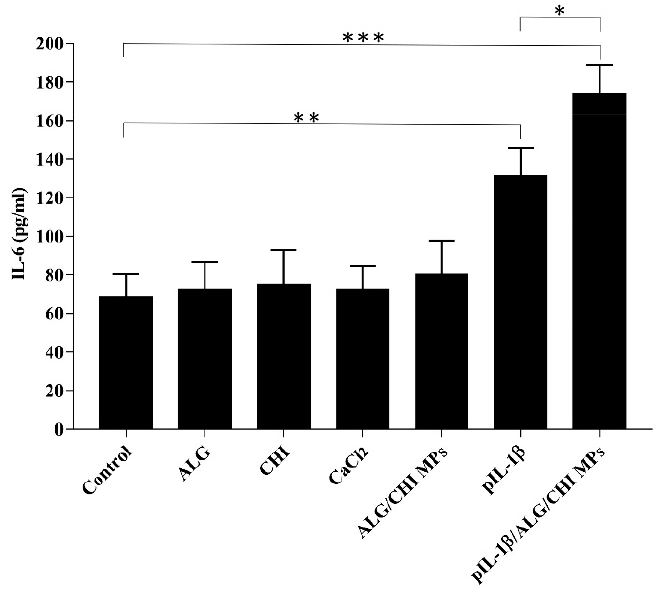
Figure 7. Effects of alginate, chitosan, CaCl 2 , ALG/CHI MPs, pIL-1 β , and pIL-1 β /ALG/CHI MPs on IL-6 abundance in lysates of the porcine fibroblast line ST. ST cells were cultured in Dulbecco’s Modified Eagle’s medium (Control) or 10 ng/mL of alginate, chitosan, CaCl 2 , ALG/CHI MPs, pIL-1 β , or pIL-1 β /ALG/CHI MPs for 8 h. Cells were lysed, and IL-6 abundance was measured using a porcine-specific ELISA. Data represent the mean ± standard deviation of triplicate determinations. * p < 0.05, pIL-1 β vs. pIL-1 β /CHI/ALG MPs; ** p < 0.01, pIL-1 β vs. control; *** p < 0.001, pIL- 1 β /CHI/ALG MPs vs. control.